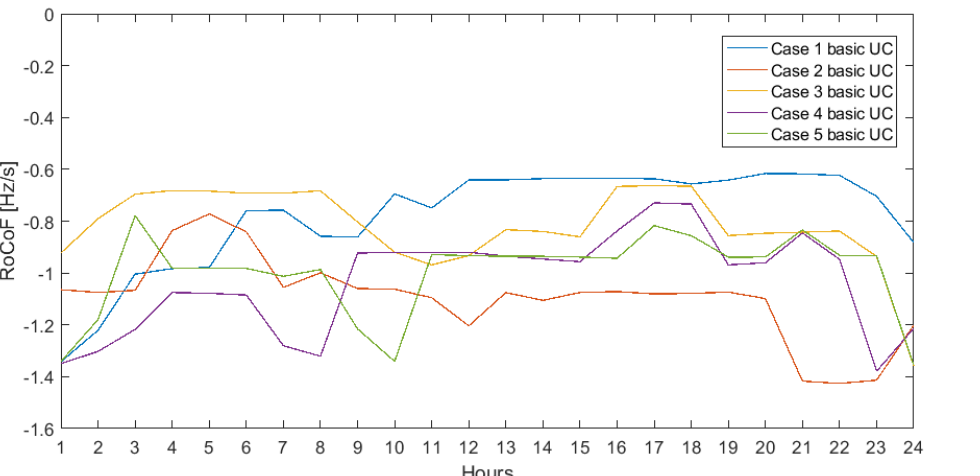
Figure 5. 24-h RoCoF for five cases applying bUC.